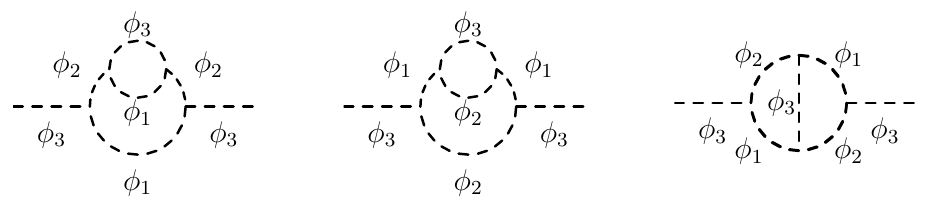
Figure 5. φ 3 self energy at the two-loop